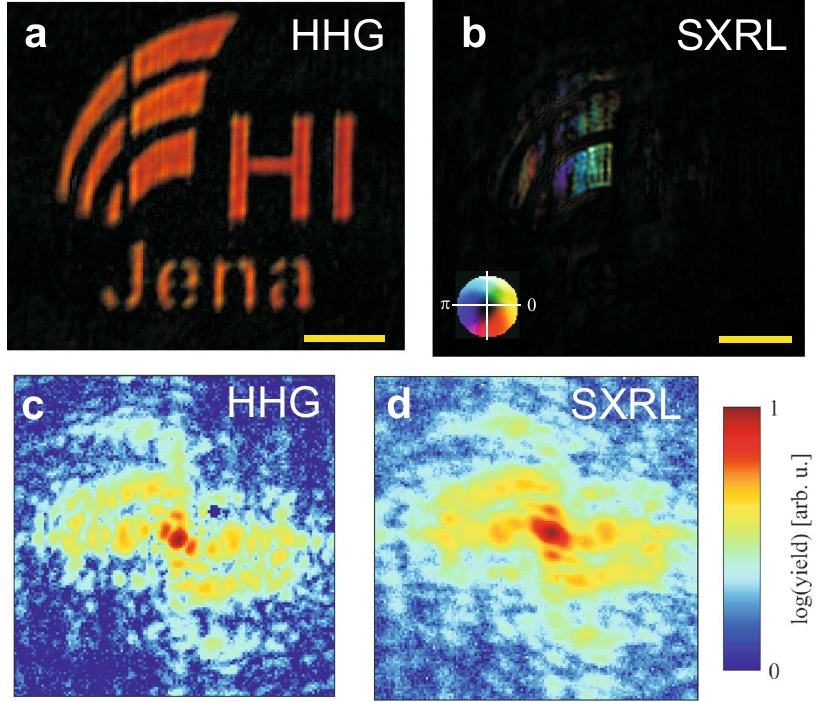
Figure 5. Comparison of CDI using a HHG and SXRL source. The reconstruction of the object from the diffraction pattern captured using a HHG source ( a ) shows the object (Fig. 4c) in detail, while the reconstruction from the SXRL ( b ) is incomplete and features unstable phases. Comparing the raw data measured (( c ) and ( d )) the effect of limited transverse coherence of the SXRL becomes obvious. In Panels (a) and (b) the complex-valued object space is depicted where the brightness and hue encode the amplitude and phase respectively (see inset in Panel (b)). The scale bars are one micron. In Panels (c) and (d) the measured intensity of the diffraction pattern around the central speckle is depicted. The image area shown was cropped for easy comparison of the